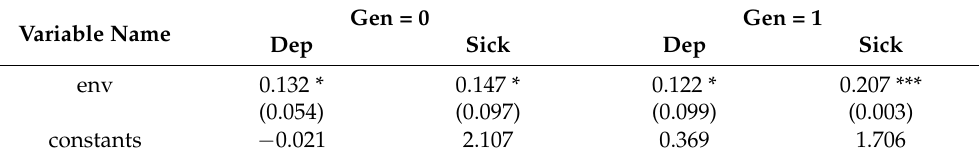
Table 10. The impact of environmental perception on the health status of different gender groups.